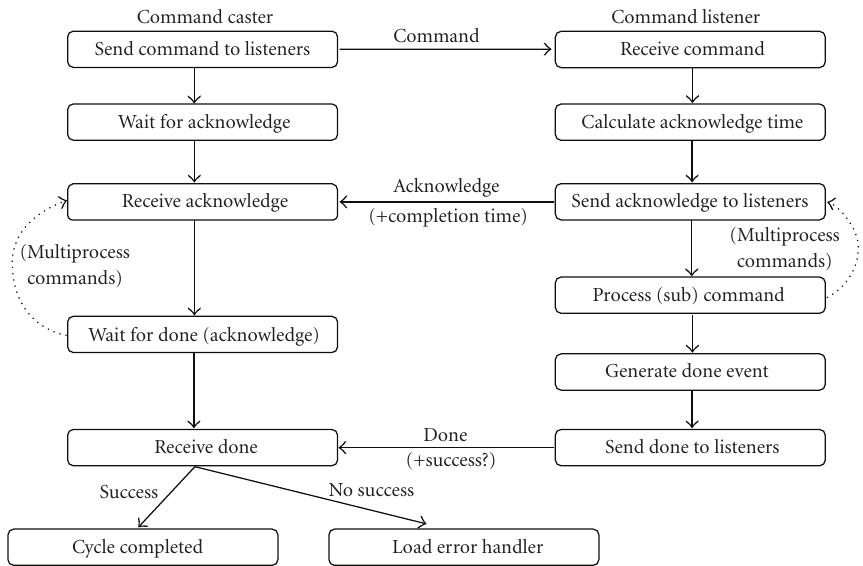
Figure 2: The basic messaging system of the STELLA control system